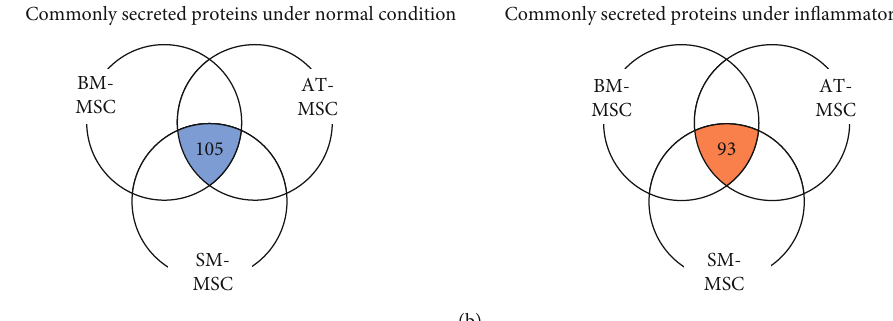
Figure 2: Mass spectrometry analysis of the conditioned medium for BM-, AT-, and SM-MSCs. (a) Work fl ow of the preparation of conditioned medium for LC-MS/MS. (b) Venn diagram of commonly secreted proteins by three donors for each MSC type. A total of 105 and 93 proteins were commonly secreted by BM-, AT-, and SM-MSCs (all-MSCs) under normal and in fl ammatory conditions,